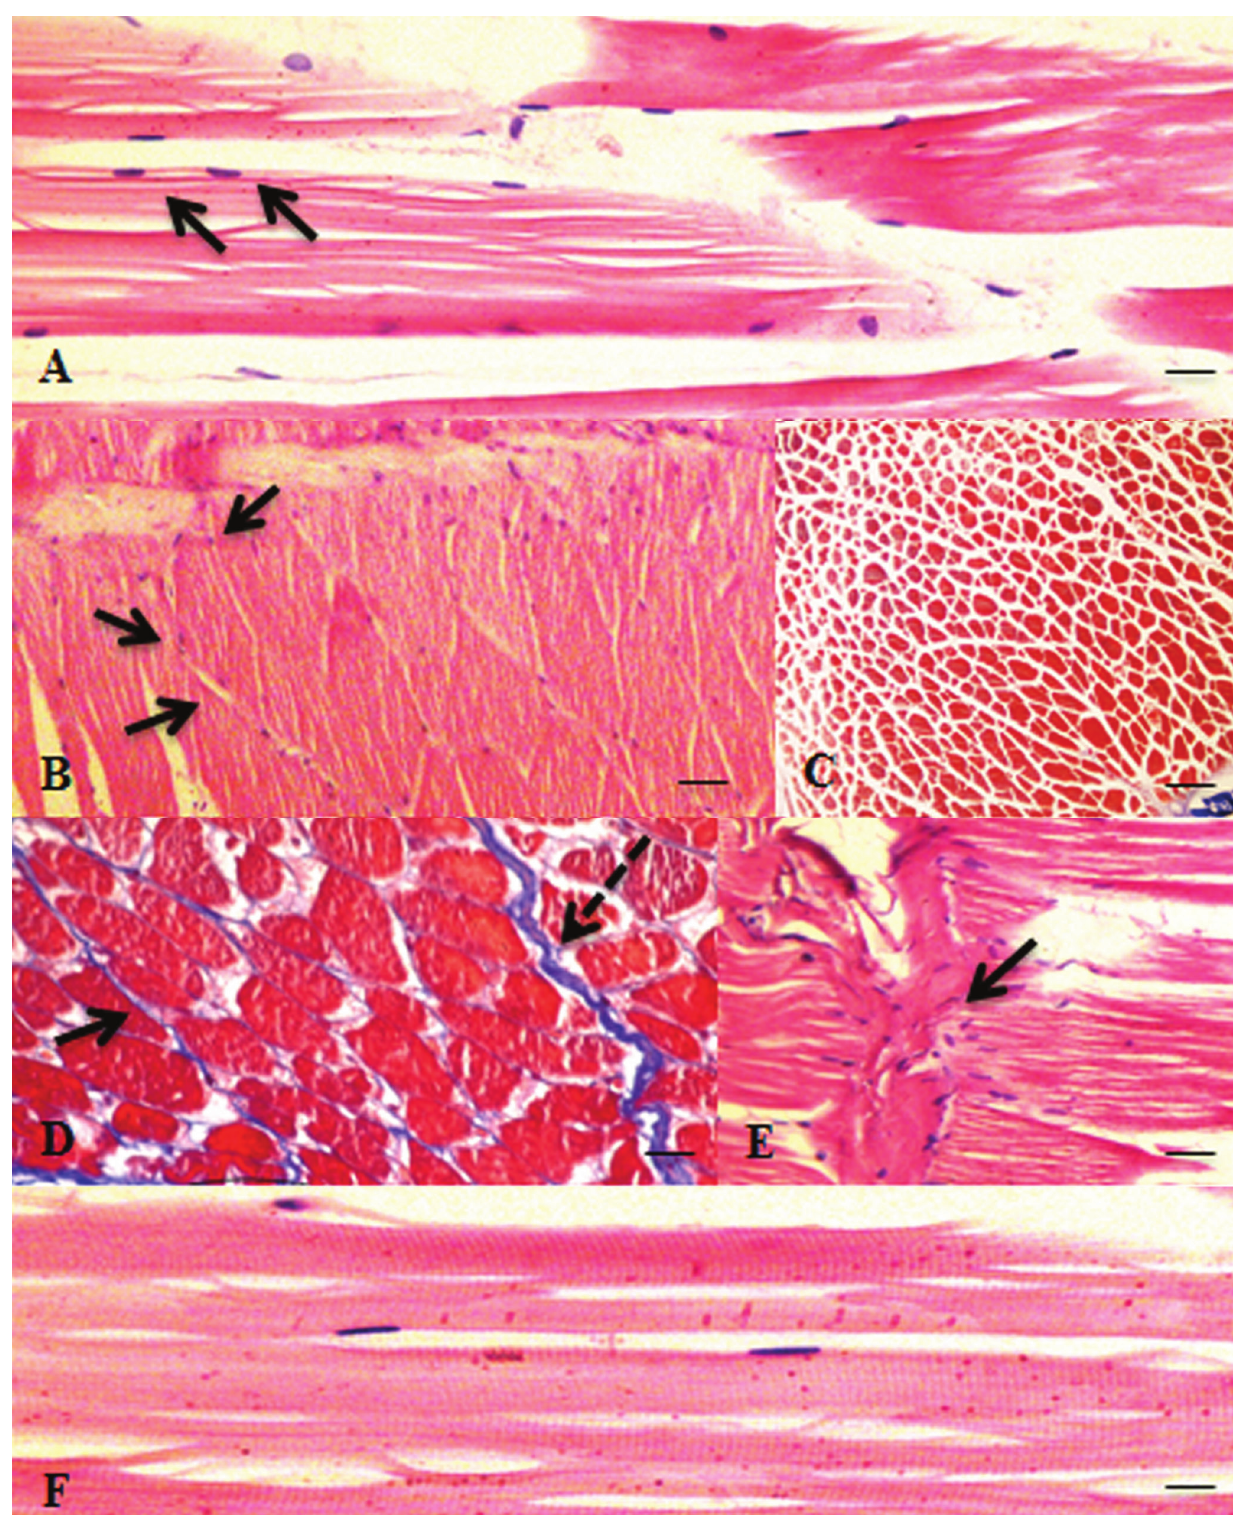
Fig. 1. Muscle tissue organization in Colossoma macropomum . A . Multinucleated fibers with peripheral nuclei (arrow). Longitudinal section. HE. (Bar = 25 μm ). B . Nuclei located at the periphery of the muscle fiber (arrow). Transverse section. HE. (Bar = 50 μm ). C . Fascicle organized in perimysium and endomysium. Transverse section. HE. (Bar = 100 μm ) . D . Connective tissue surrounding the endomysium (dotted arrow) and perimysium (black arrow). Transverse section. Masson trichrome. (Bar = 50 μm ) . E . Mobilization of cells in the muscle fiber insertion in connective tissue (black arrow), many nuclei are observed. Longitudinal section. HE. (Bar = 50 μm ) . F . Sarcomere with striations along the muscle fiber. Longitudinal section. HE. (Bar = 25 μm )